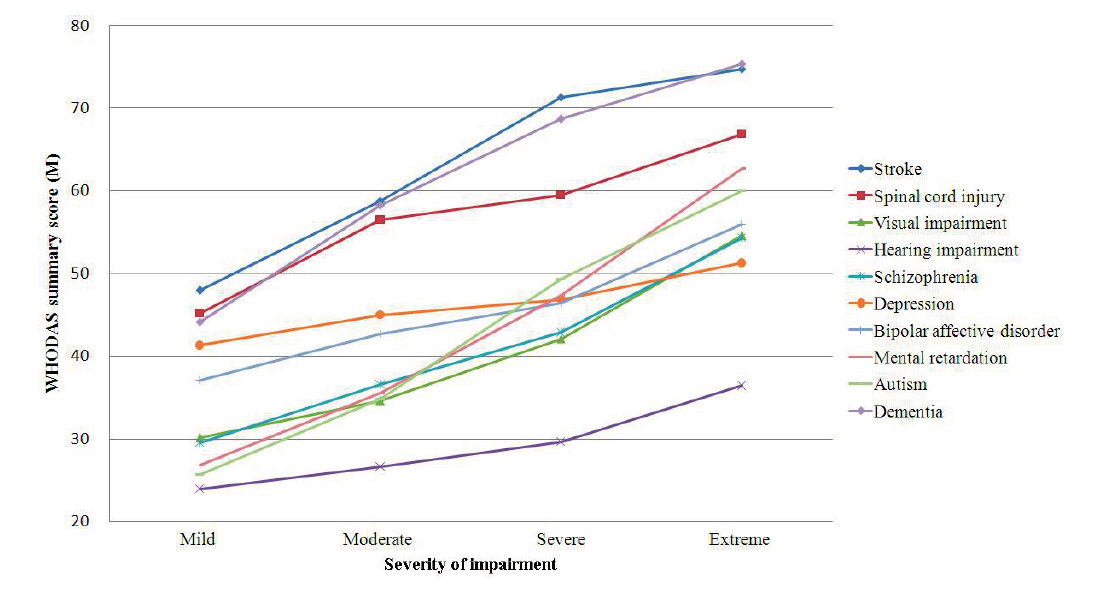
Figure 2. Effect of severity of impairment on WHODAS 2.0 scores: major disabling diseases.The severity of impairment is determined based on the highest qualifier of body functions (b codes) and structural components (s codes) of the International Classification of Functioning, Disability and Health (ICF) (mild: 5%–24% impairment, moderate: 25%–49% impairment, severe: 50%–95% impairment, complete: 96%–100%